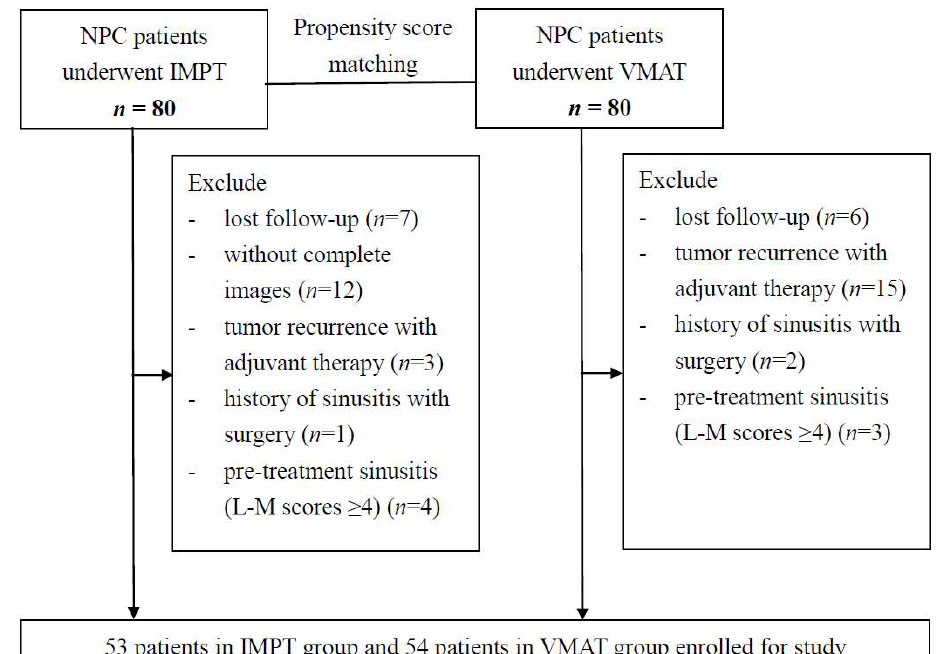
Figure 1. Flow chart of patient selection